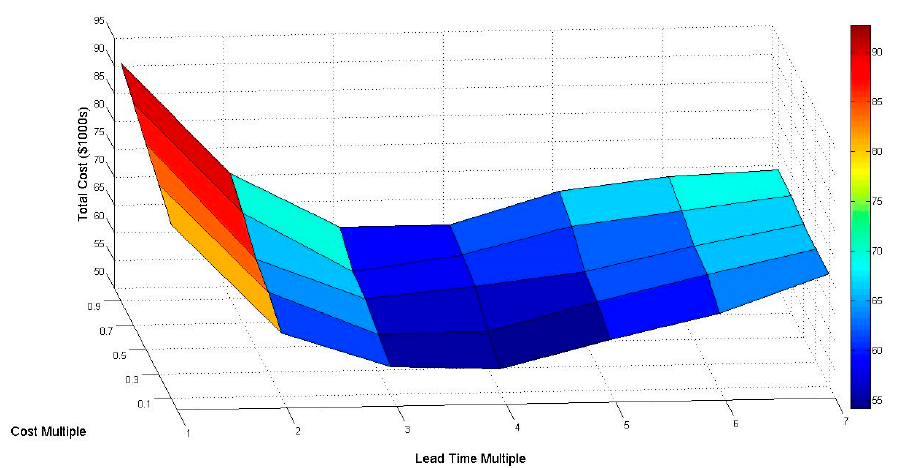
Figure 4. Results for the small instance set.